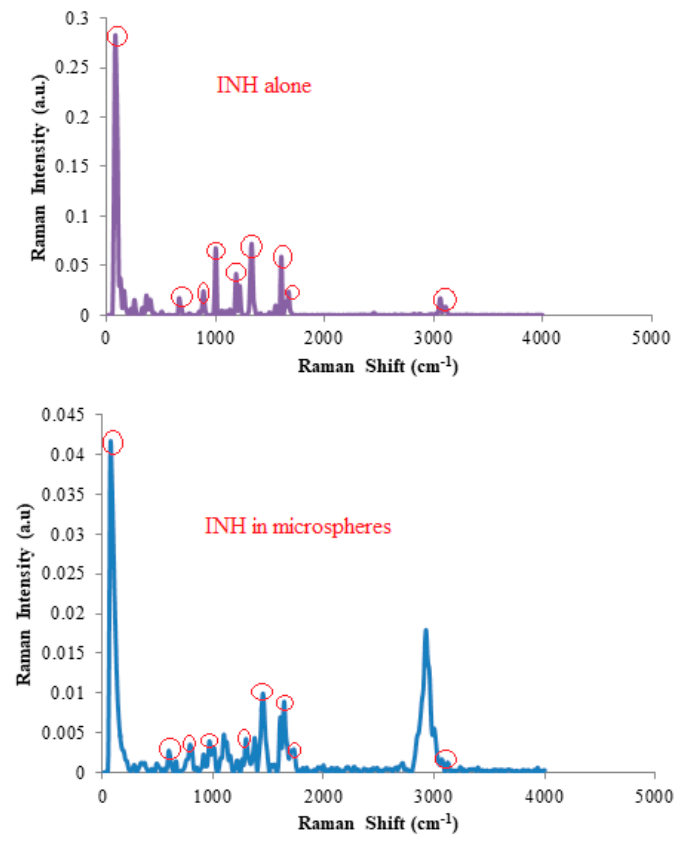
Figure 3. FT Raman spectral data for INH alone and in microspheres.